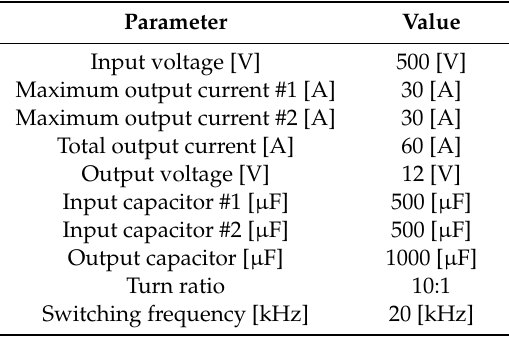
Table 1. Parameters of ISOP converter in